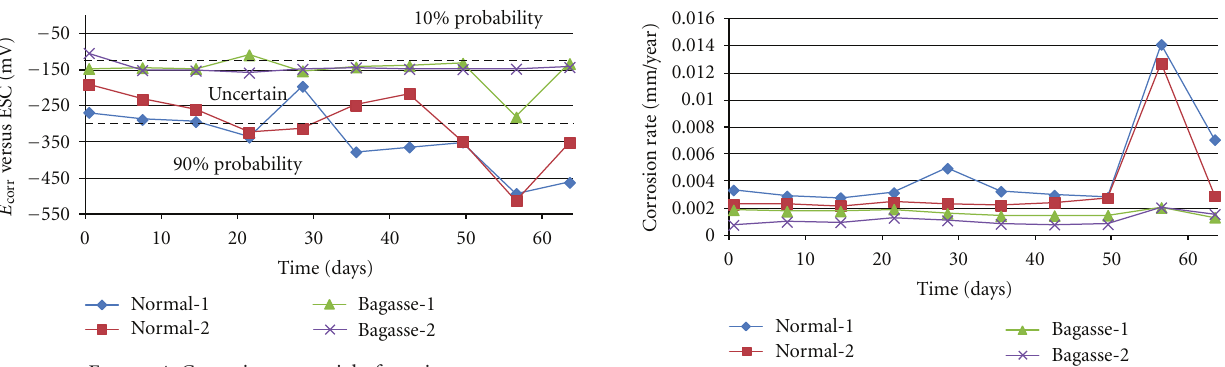
Figure 6: Corrosion rate of